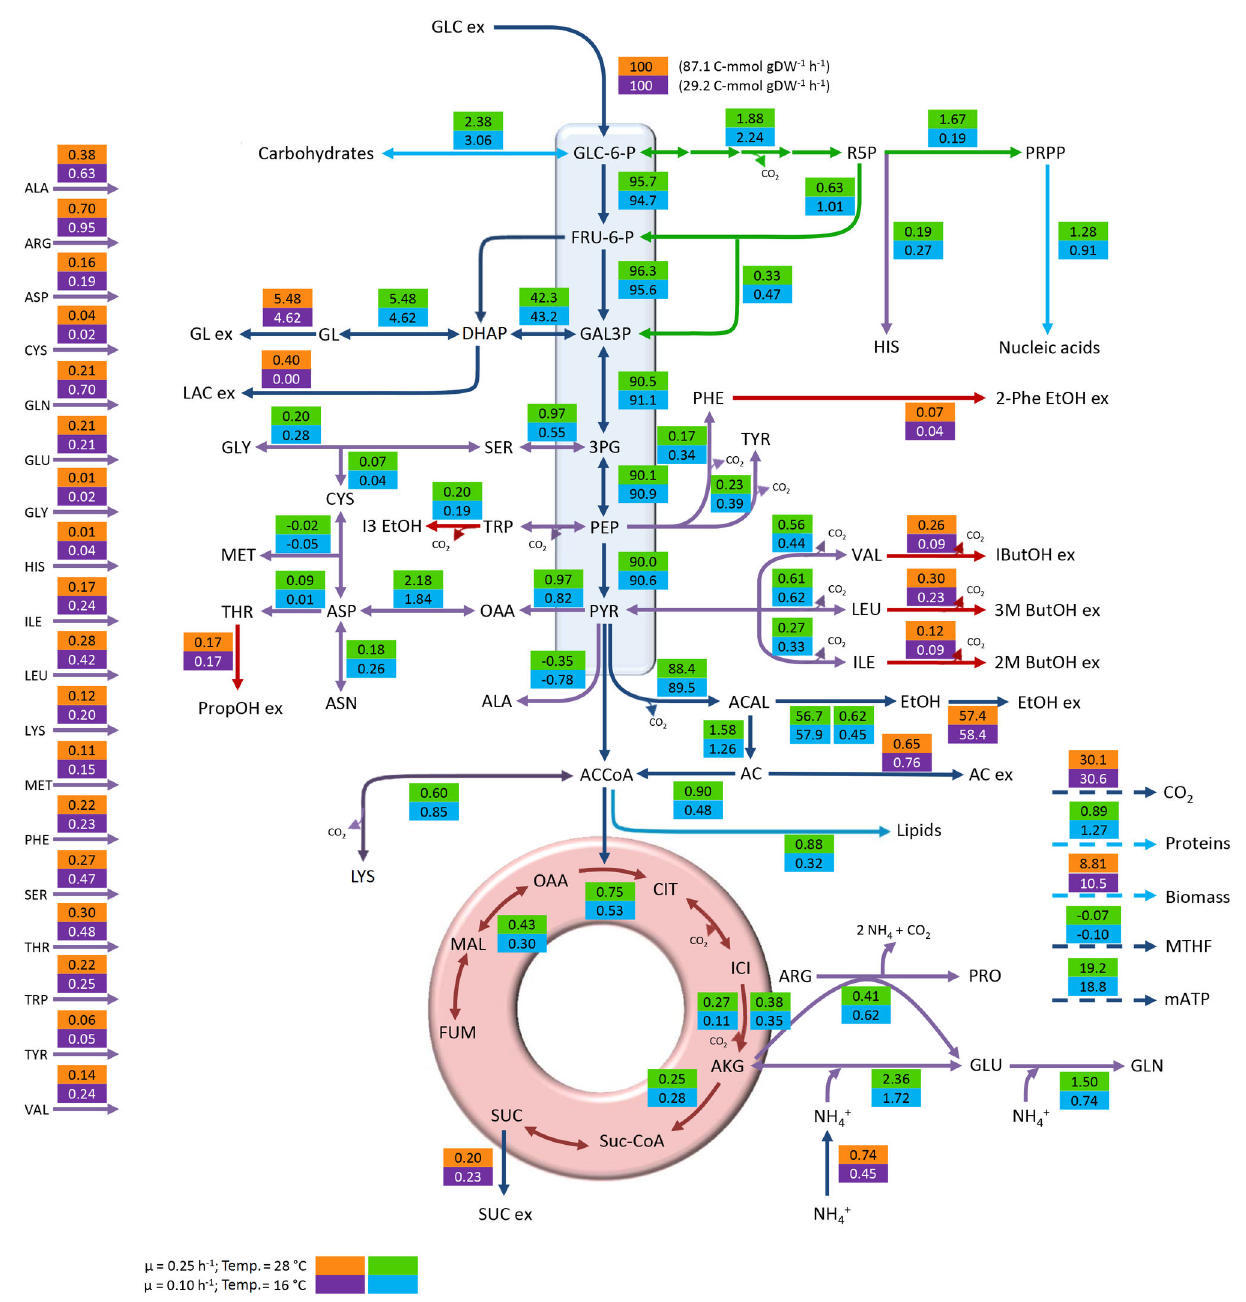
Figure 1. Distribution of metabolic fluxes at 240 g L -1 glucose expressed as C-mmol per 100 C-mmol glucose. The measured specific glucose uptake is shown next to the normalized value. Orange/purple boxes: measured and reconciled values; Green/blue boxes: calculated